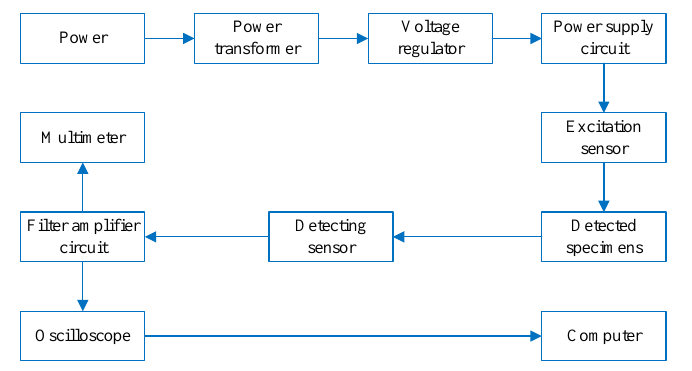
Figure 5. Block diagram of electromagnetic testing system.